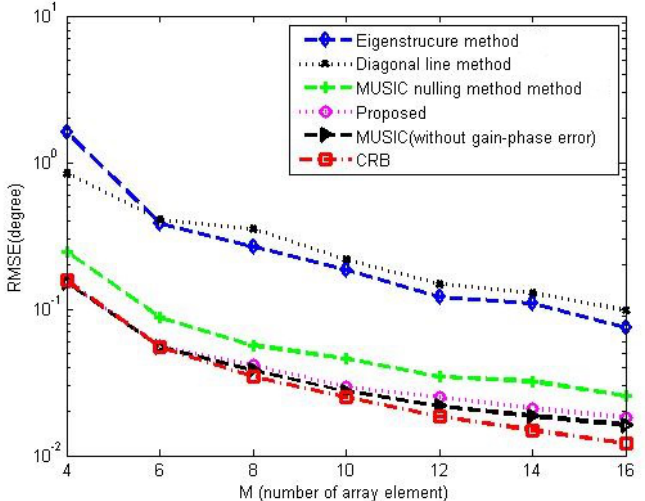
Figure 14. DOA performance comparison among the corresponding gain-phase estimation methods versus number of array element in the case of random gain-phase errors, CSR = 30 dB, SNR = 20 dB, K 0 = 20, T = 80, N = 40, T 0 = 40.